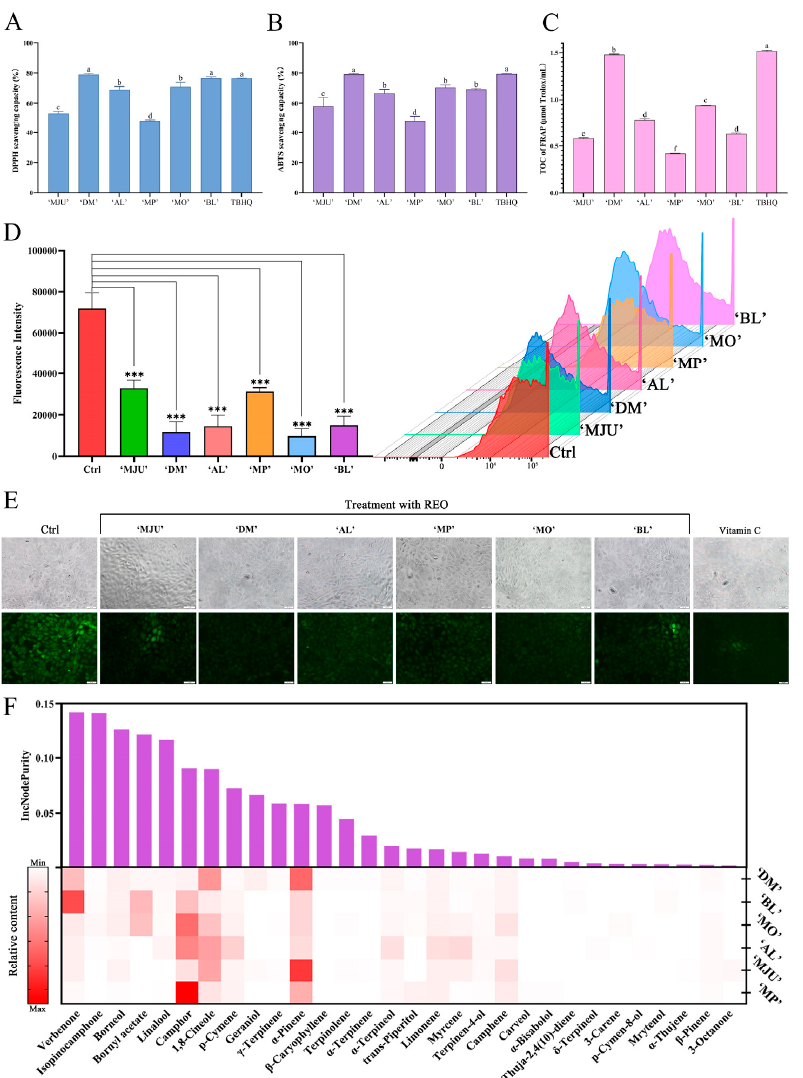
Figure 2. The antioxidant capacity of REOs by different assays. ( A ) DPPH assay. ( B ) ABTS assay. ( C ) FRAP assay. ( D ) The scavenging capacity of ROS in HaCaT. ( E ) The change of ROS intensity under fluorescence microscope. ( F ) Random forest regression analysis model based on components and the overall antioxidant activity of TOPSIS. Data were expressed as means ± standard deviation (SD) (*** p < 0.001). Means with different letters in the same column are significantly different ( p < 0.05).